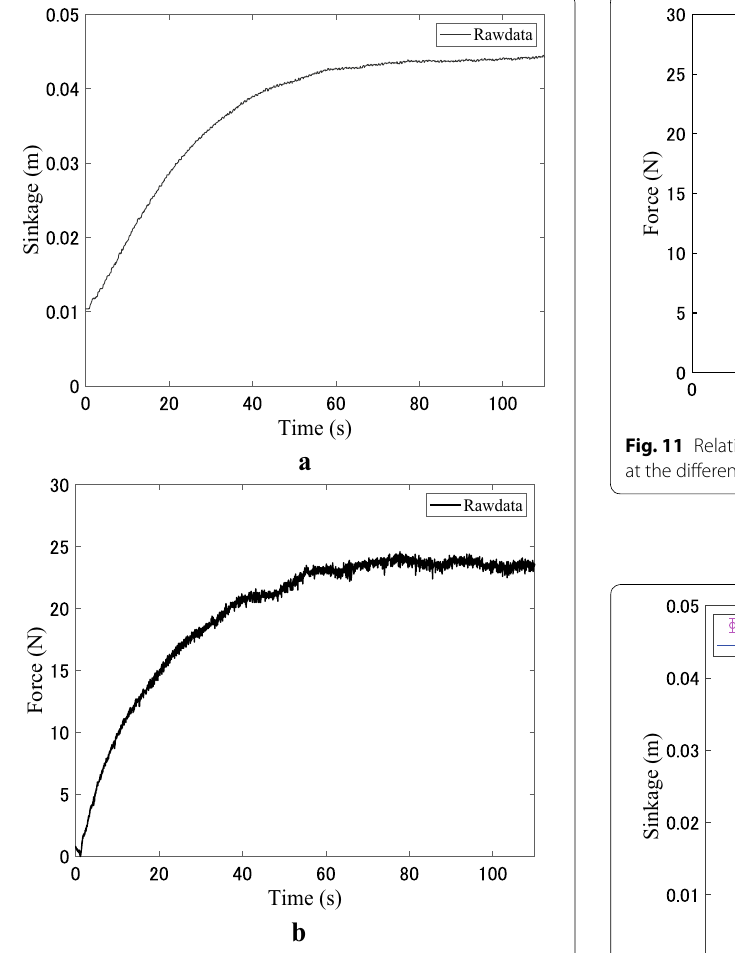
Fig. 10 Raw data of the sinkage and resistance force. Diameter 0.17